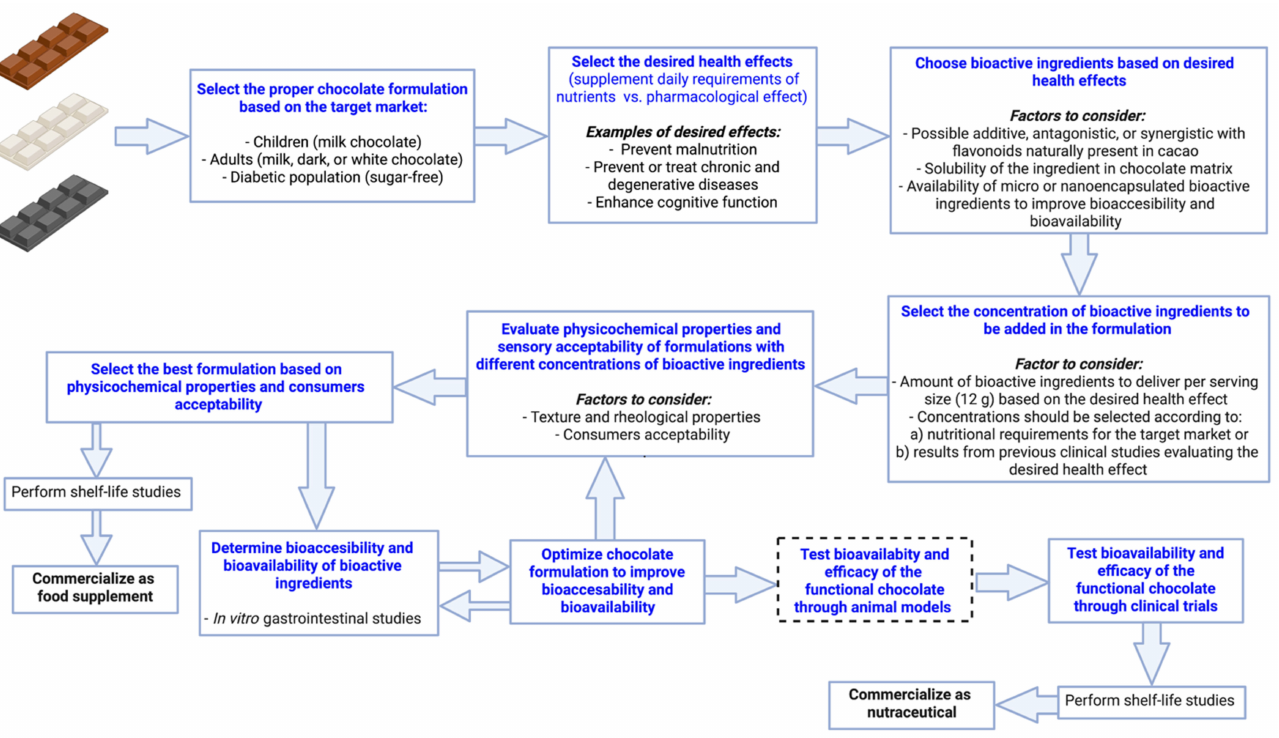
Figure 2. Proposed general protocol to develop functional chocolates to be commercialized in the food supplement or nutraceutical markets. The step marked with dashed lines could be avoided depending on the bioactive compounds selected and their concentrations in the formulations. The in vivo studies with animal models and the clinical trials need previous approval by an ethical